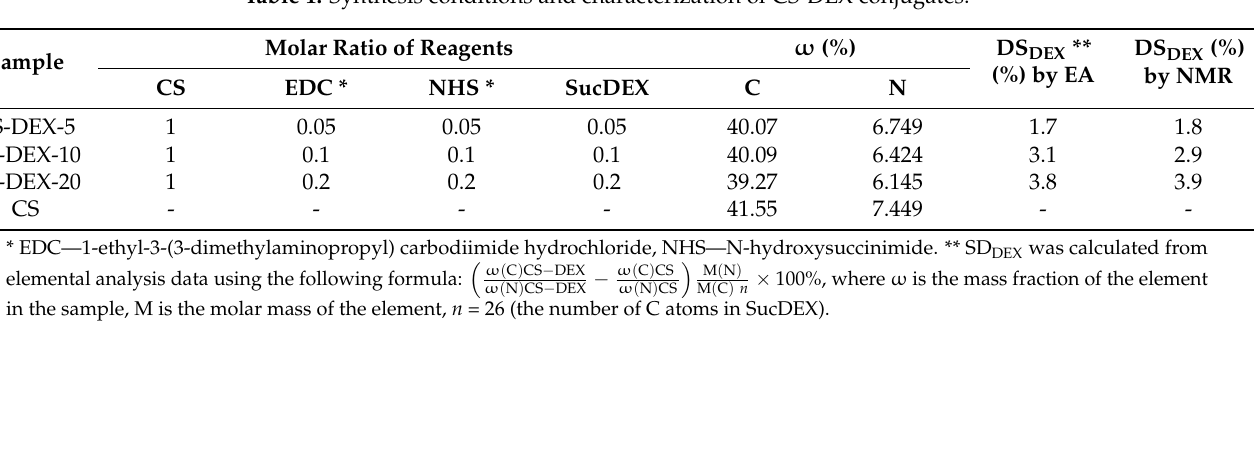
Figure 1. Synthesis scheme for SucCS-DEX. Table 1. Synthesis conditions and characterization of CS-DEX conjugates.